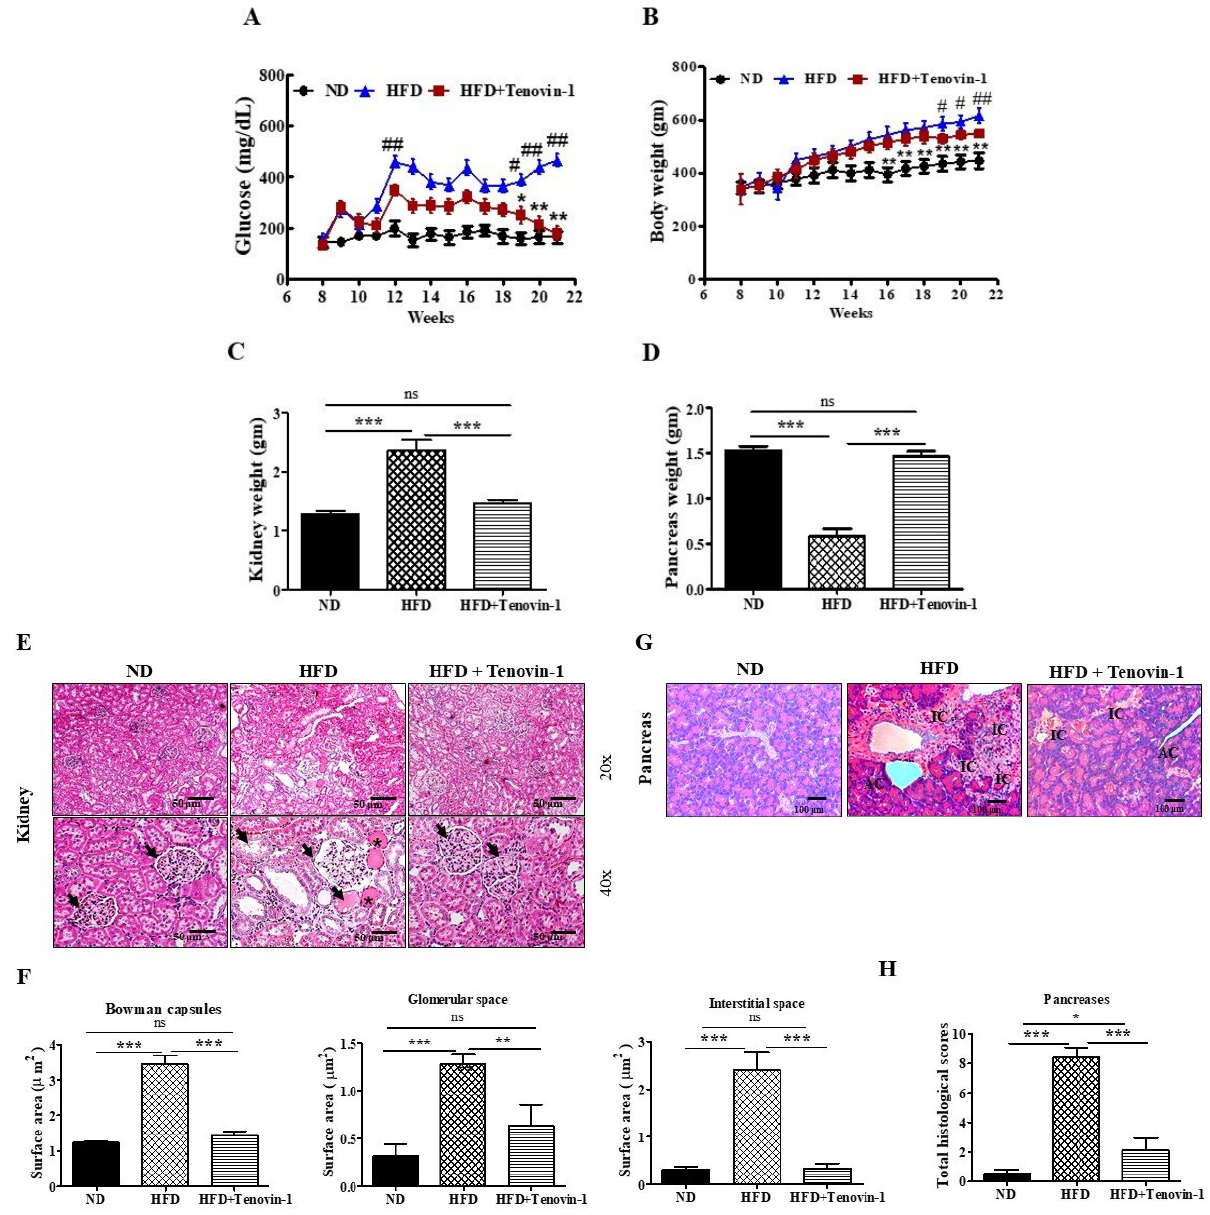
Figure 2. Effect of Tenovin ‐ 1 on glycemic status and microscopic appearances of the kidneys in HFD ‐ induced diabetic rats. HFD ‐ induced body weight gains in ZDF rats. ( A ) Effect of Tenovin ‐ 1 on fasting blood glucose concentration (mg/dL). ( B ) Body weight significantly increased in the HFD ‐ fed rats, which was normalized following treatment with Tenovin ‐ 1. The values are presented as the mean ± S.D. of six rats per group. Statistical analysis was performed through one ‐ way analysis of variance (ANOVA) followed by Tukey’s HSD post hoc test for multiple comparisons. * p < 0.05, ** p < 0.01, and *** p < 0.001 as compared with the group that received a normal diet (ND); # p < 0.05, ## p < 0.01, and ### p < 0.001 as compared with the HFD ‐ fed group. ND, normal diet; HFD, high ‐ fat diet. ( C ) Effect of Tenovin ‐ 1 on relative kidney weight. ( D ) Effect of Tenovin ‐ 1 on relative pancreas weight. ( E ) Histological alterations in kidney tissue stained with H&E stain. At 21 weeks, the expanded cortex, glomerular sclerosis (arrow heads), expansion (asterisk), and dilation were visible in the rats with HFD ‐ induced diabetes. Tubular dilation, fibroplasia, and interstitial nodular sclerosis were observed in the medulla. HFD ‐ fed rats treated with Tenovin ‐ 1 showed renal cortexes (RCs) of a normal size, low incidences of medullar and tubular injury, and normal histological architecture comprising thin tubules and collecting ducts (magnification 200×; bar = 50 μ m). ( F ) Quantitative analysis of the Bowman capsules, glomerular